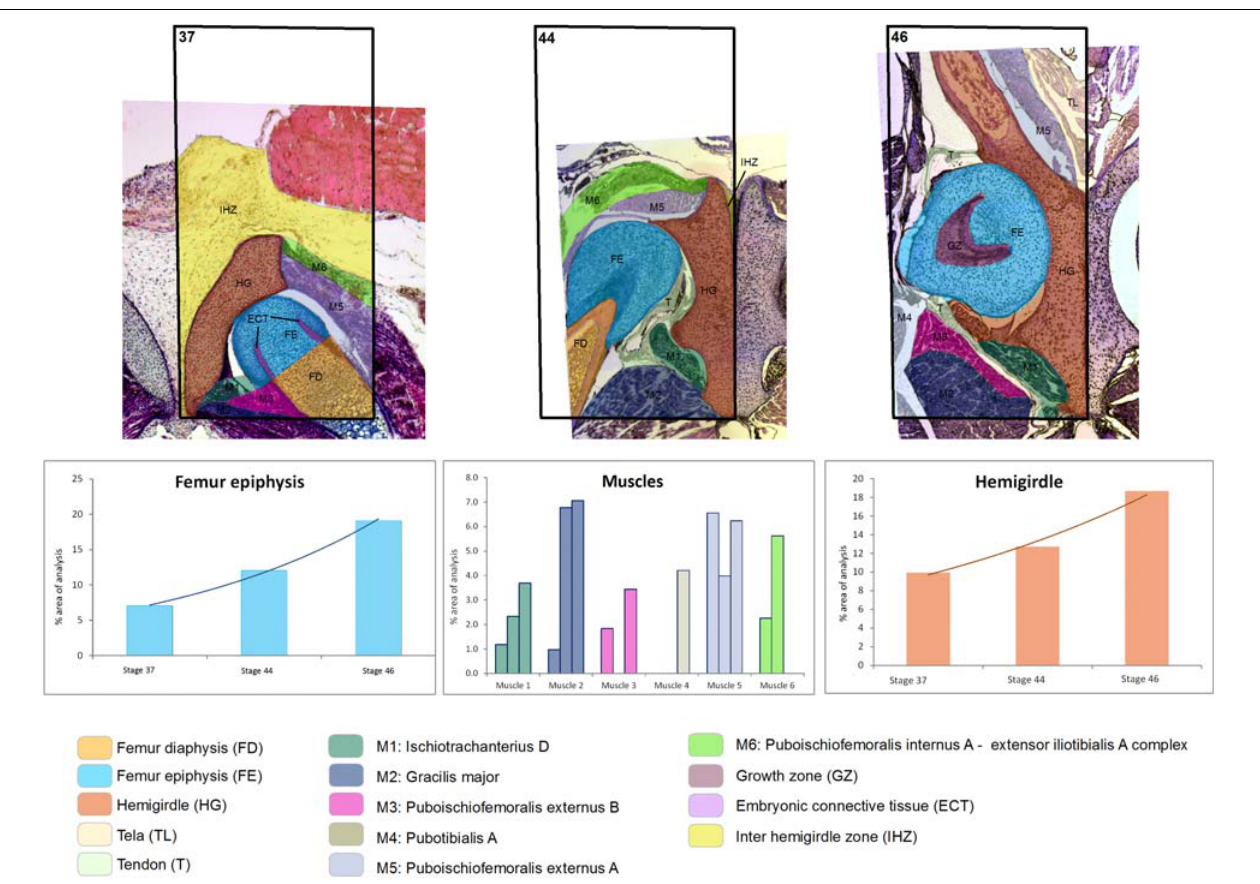
FIGURE 2 | Boana riojana . Selected area and the ontogenetic Stages 37–44–46 showing the increase in size and change of location of the pelvic girdle tissues and structures. Note the embryonic connective tissue restricted to the future osteochondral ligament. In the frequency histograms the growth of the structures is